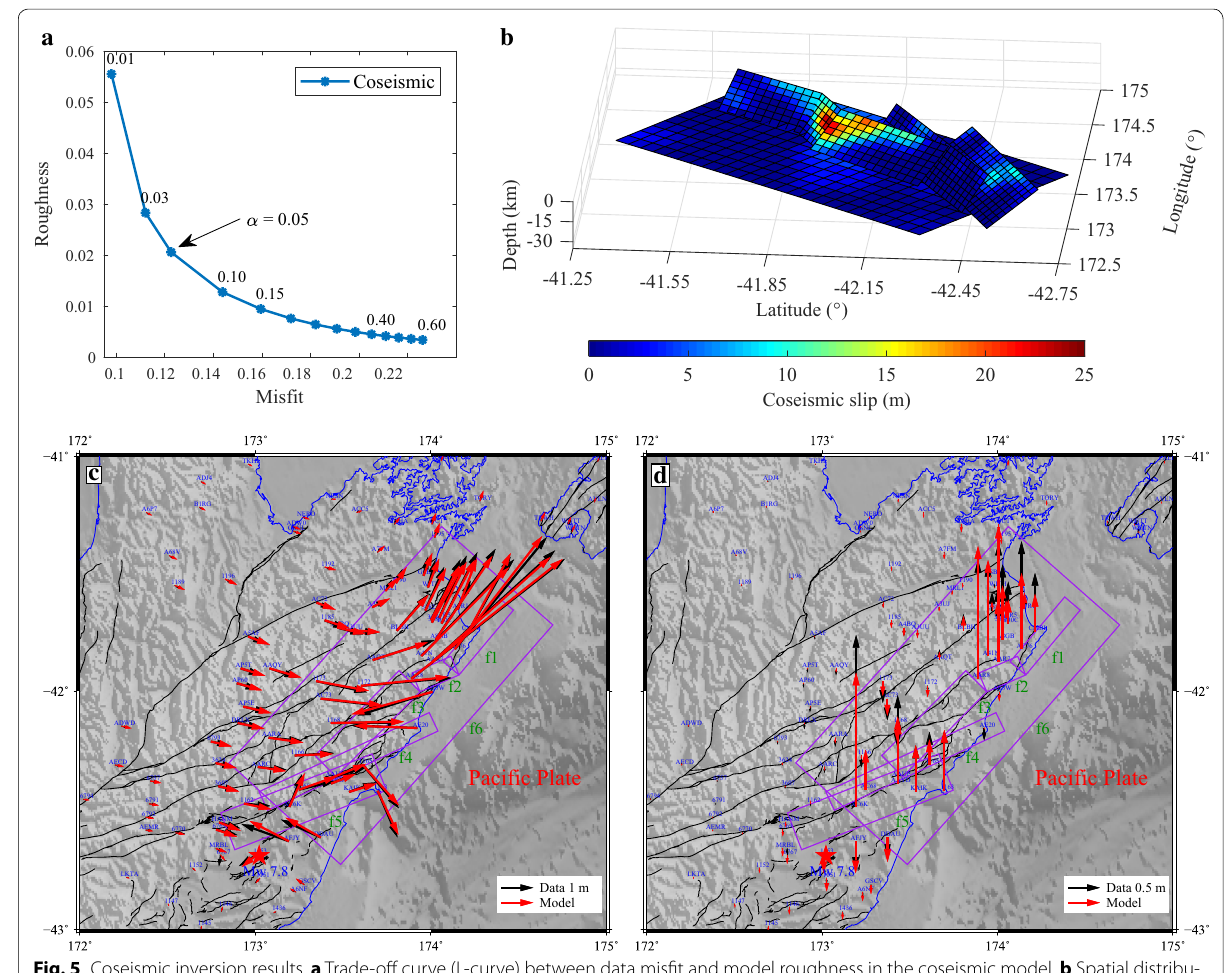
Fig. 5 Coseismic inversion results. a Trade-off curve (L-curve) between data misfit and model roughness in the coseismic model. b Spatial distribu- tion of the coseismic slip. c and d Horizontal and vertical displacement fields with GPS observations (black arrows) and model predictions (red arrows), respectively. The six purple rectangles represent the surface projection of the faults in the coseismic